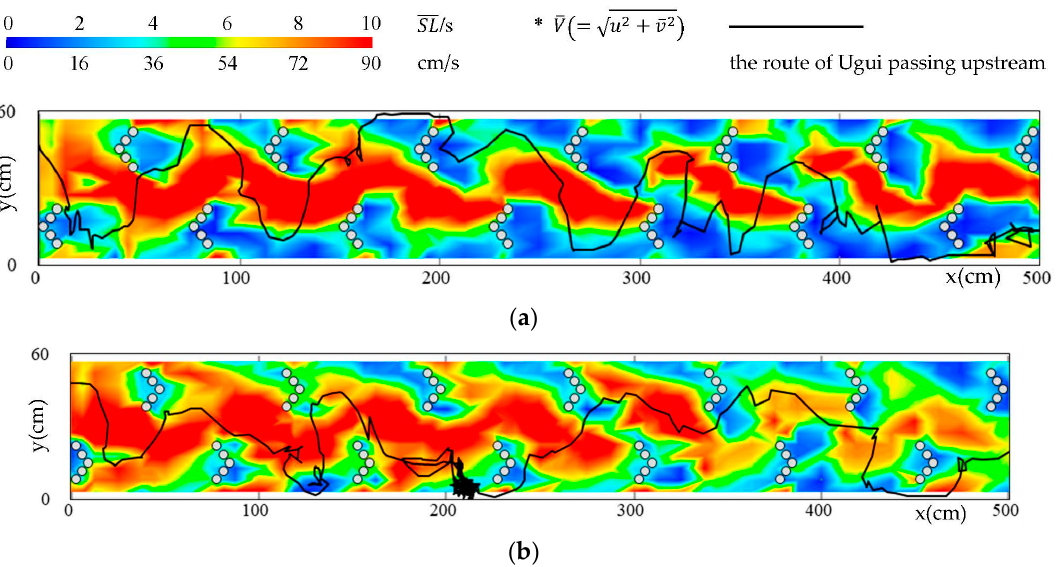
Figure 11. Flow velocity contour diagram of the fishway and the route of Ugui passing upstream in each case of this study: ( a ) Run7-cu in Case 7; ( b ) Run7-cd in Case 7.